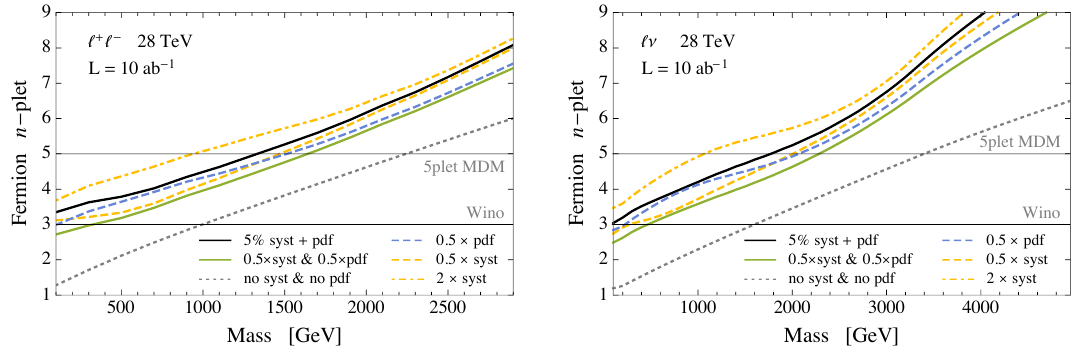
Figure 11 . Dependence of the 95% CL exclusion bounds on Majorana fermion multiplets at the HE-LHC on the PDF uncertainties and on the additional systematic